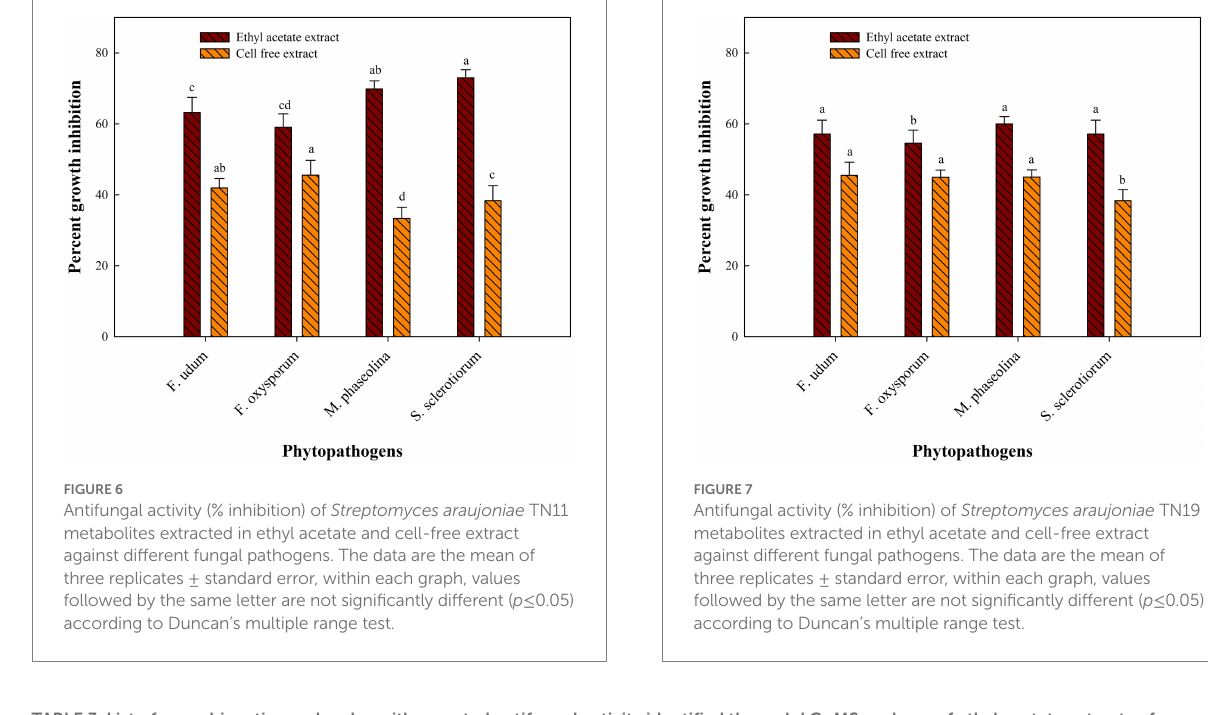
TABLE 3 List of some bioactive molecules with reported antifungal activity identified through LC–MS analyses of ethyl acetate extracts of Streptomyces araujoniae (TN11).